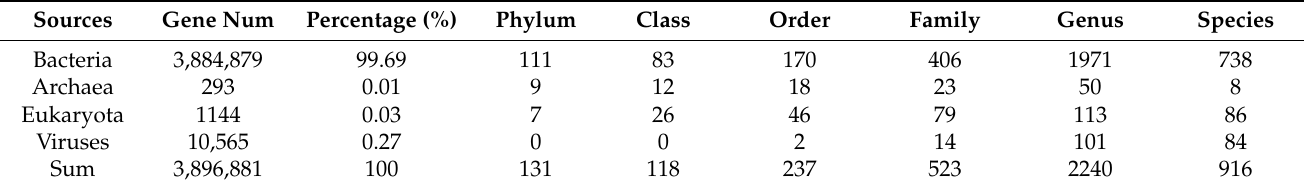
Table 2. Overall analysis of humus bacterial metagenome by Nr BLAST in NCBI taxonomy database using the MEGAN (version